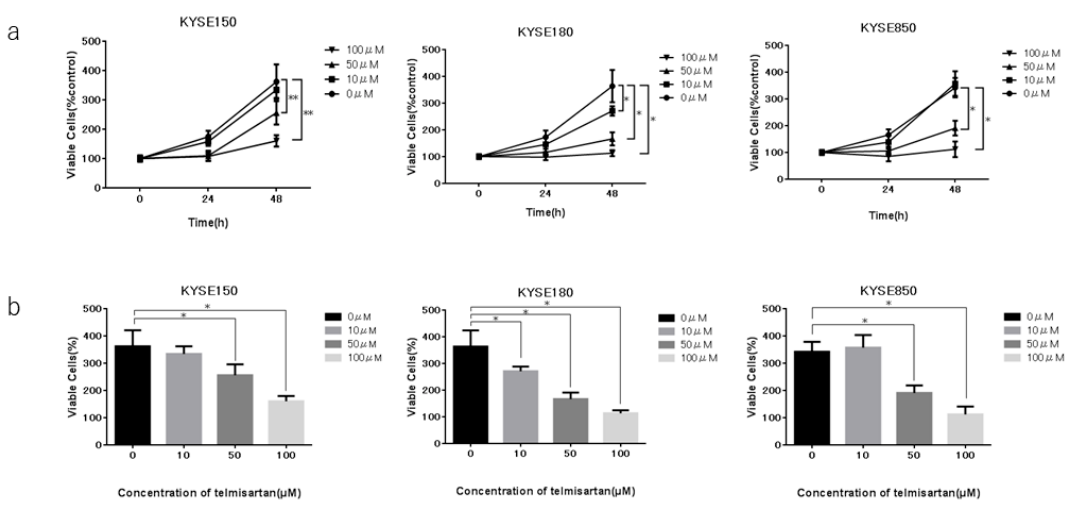
Figure 1. Effects of telmisartan on proliferation of ESCC cell lines in vitro. Telmisartan inhibited proliferation of ESCC cells. Viability of treated cells differed significantly from that of control cells.